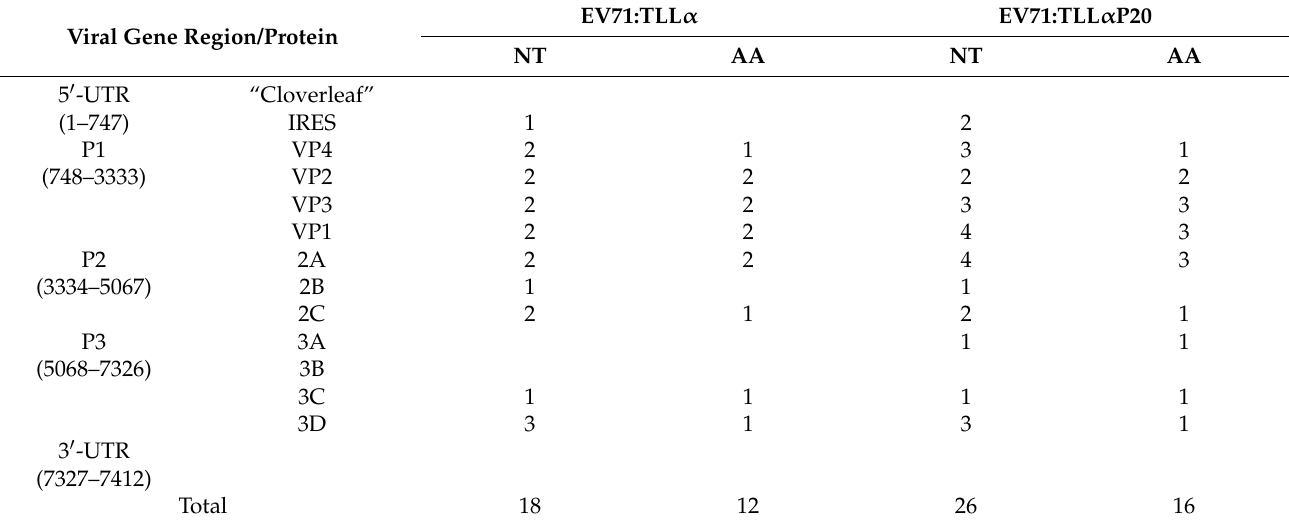
Table 1. The number of nucleotide (NT), and corresponding amino acid (AA), mutations that occurred in each of the genomic segments of EV71:TLL α and EV71:TLL α P20 compared with their original parental wild-type. Viral Gene Region/Protein